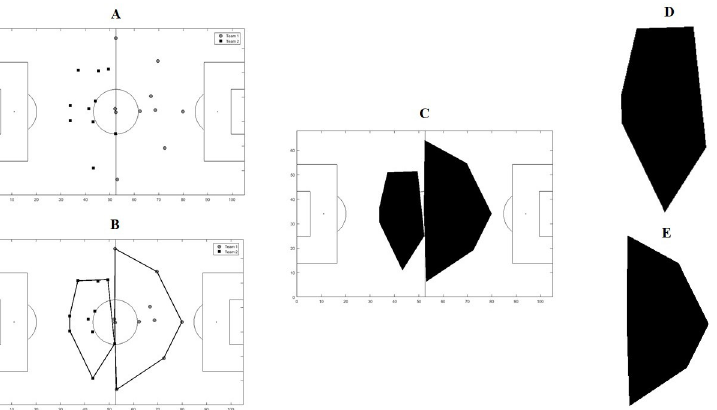
Fig 1. Steps for the construction of images of the convex polygons that represent the organization of the teams in the field: (A) Position of the players of each team at a given time; (B) Application of the quickhull technique for the construction of the convex hull; (C) Convex hull polygon in the respective field position; Images of the shapes analysed for each team, (D) Team 1 and (E) Team 2.